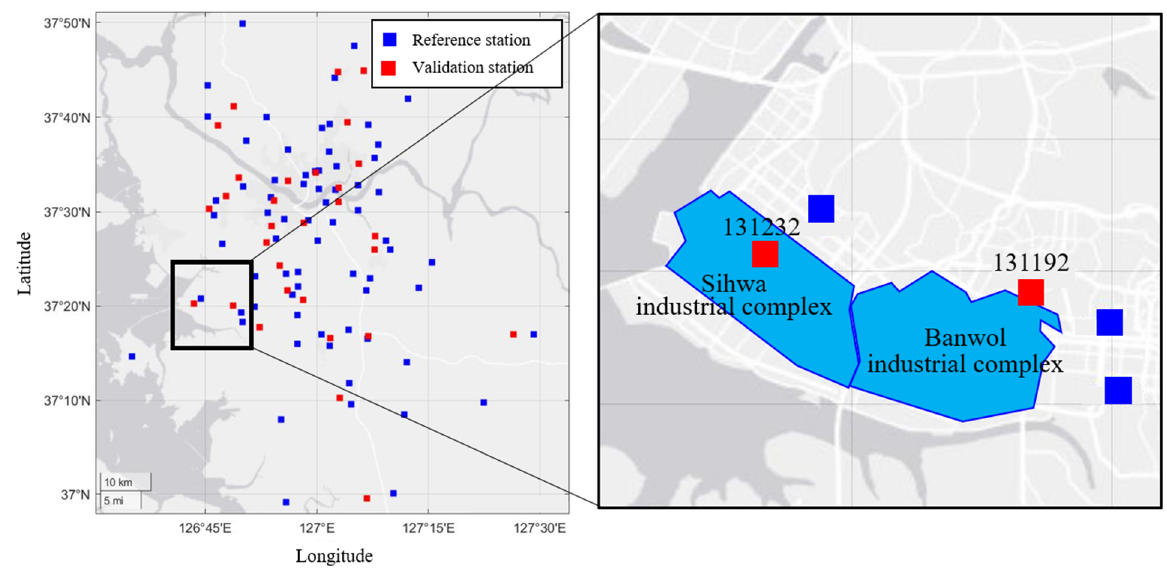
Figure 10. Locations of stations exhibiting the highest RMSE in PM estimation using the modified